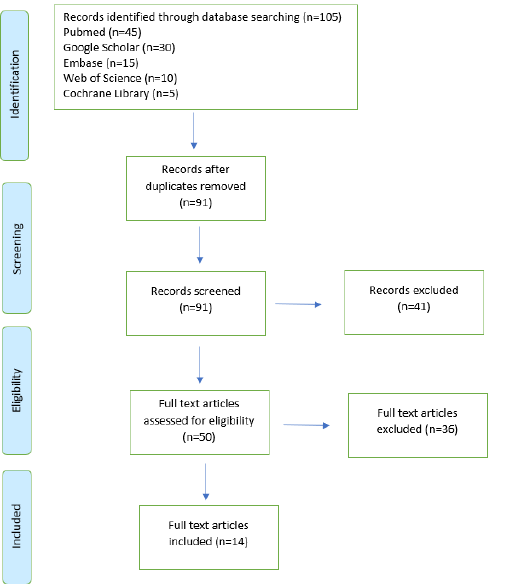
Figure 1. The study selection and eligibility screening flow according to PRISMA guidelines.